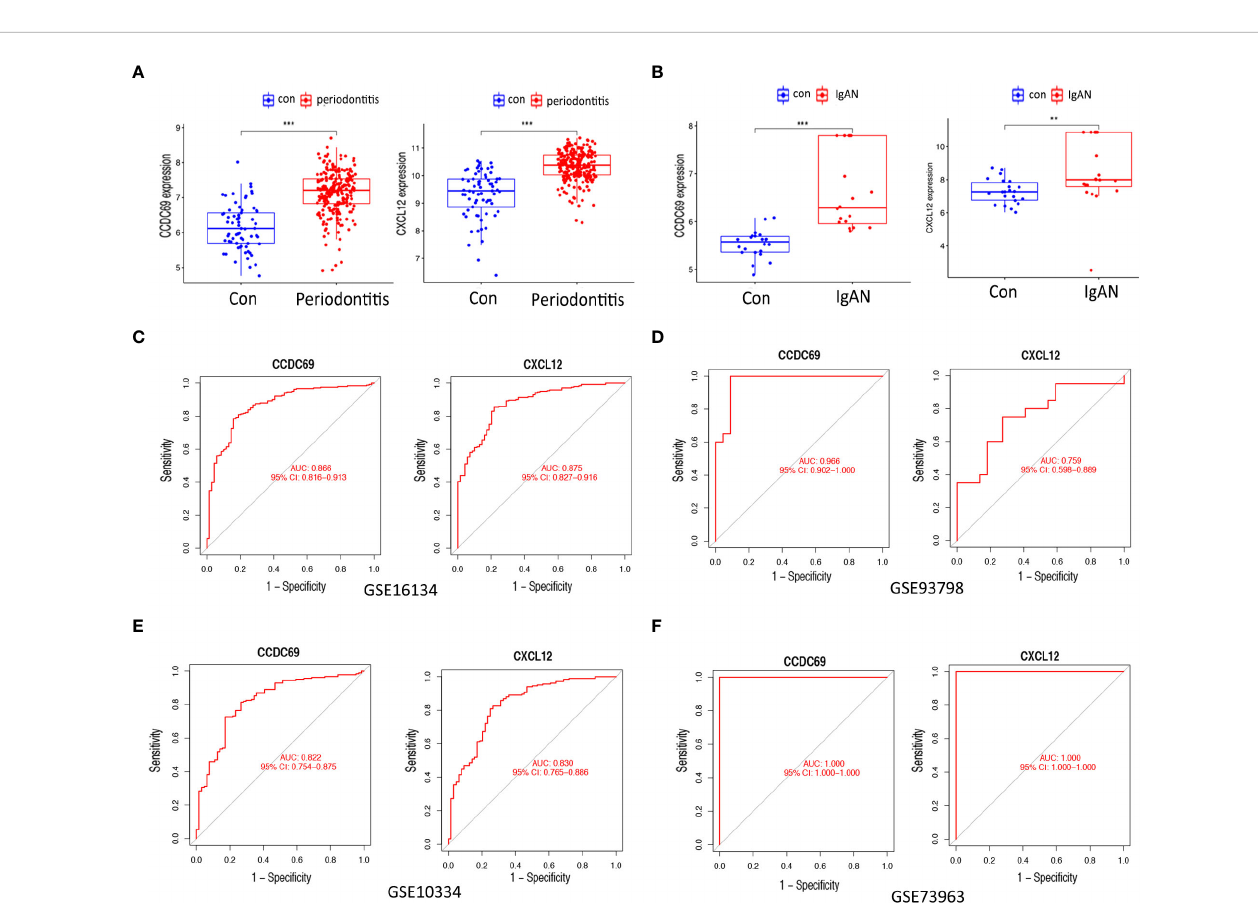
FIGURE 6 Expression pattern validation and diagnostic value. (A) Expression of CXCL12 and CCDC69 in GSE16134. (B) Expression of CXCL12 and CCDC69 in GSE93798. (C) ROC curve of the shared diagnostic genes in GSE16134. (D) ROC curve of the shared diagnostic genes in GSE93798. (E) ROC curve of the shared diagnostic genes in GSE10334. (F) ROC curve of the shared diagnostic genes in GSE73953. Con: control; IgAN: IgA nephropathy. P < 0.05; ** P < 0.01; *** P < 0.001.